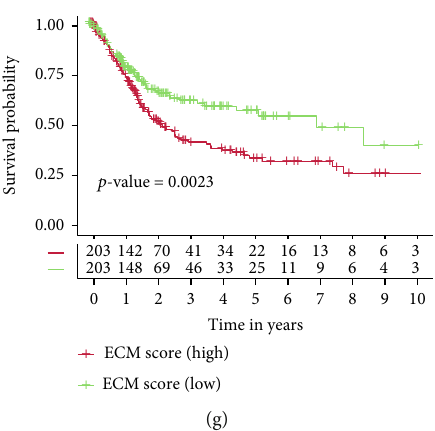
Figure 4: The construction and validation of the ECM score. (a) The distribution and overall survival data were displayed and ranked according to the ECM score. (b) The distribution of gene expression for six ECM genes between low and high ECM score groups. The Kaplan-Meier curves of overall survival time between high and low ECM score groups using the log-rank test in (c) GSE32894, (d) GSE13507, (e) GSE31684, (f) GSE32548, and (g) TCGA-BLCA